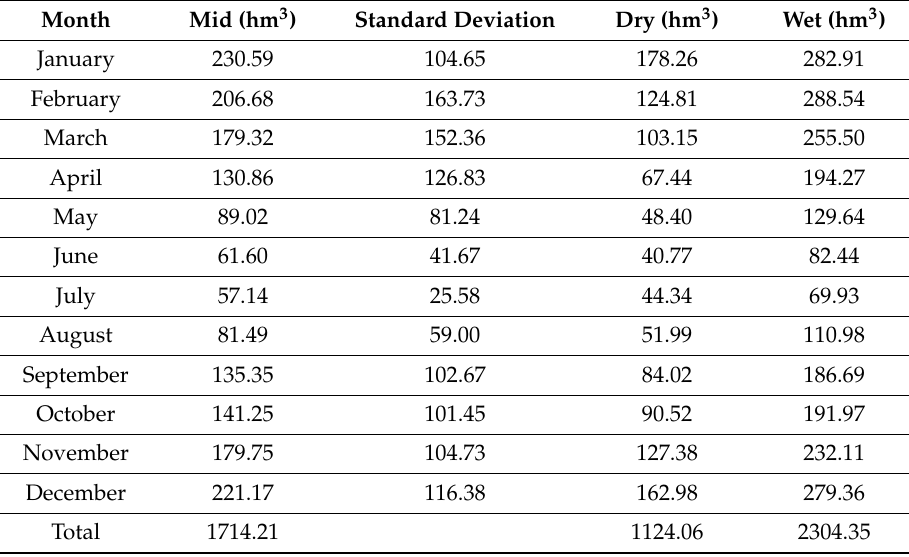
Table 3. Calculation of inflows for the three hydrological